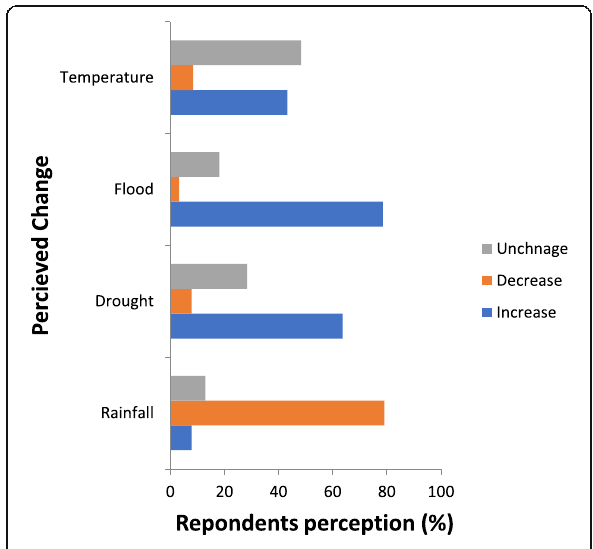
Fig. 2 Farmer ’ s perceptions of climate